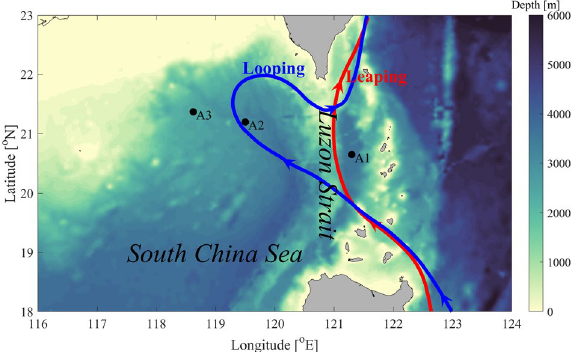
Figure 1. Bathymetry (shading, unit: m) of the northern SCS. The looping and leaping paths of the Kuroshio are denoted by blue and red curves, respectively. Black dots (A1–A3) denote observational stations in Li 3